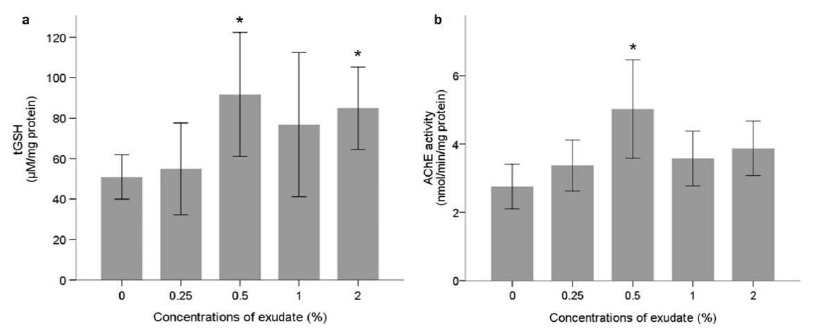
Figure 2. ( a ) Levels of total glutathione (tGSH) in M. galloprovincialis muscle after 96 h of exposure; ( b ) Acetylcholinesterase (AChE) activity in M. galloprovincialis muscle after 96 h of exposure. All values are presented as mean ± SE. * denotes a statistically significant difference compared to control (0%).